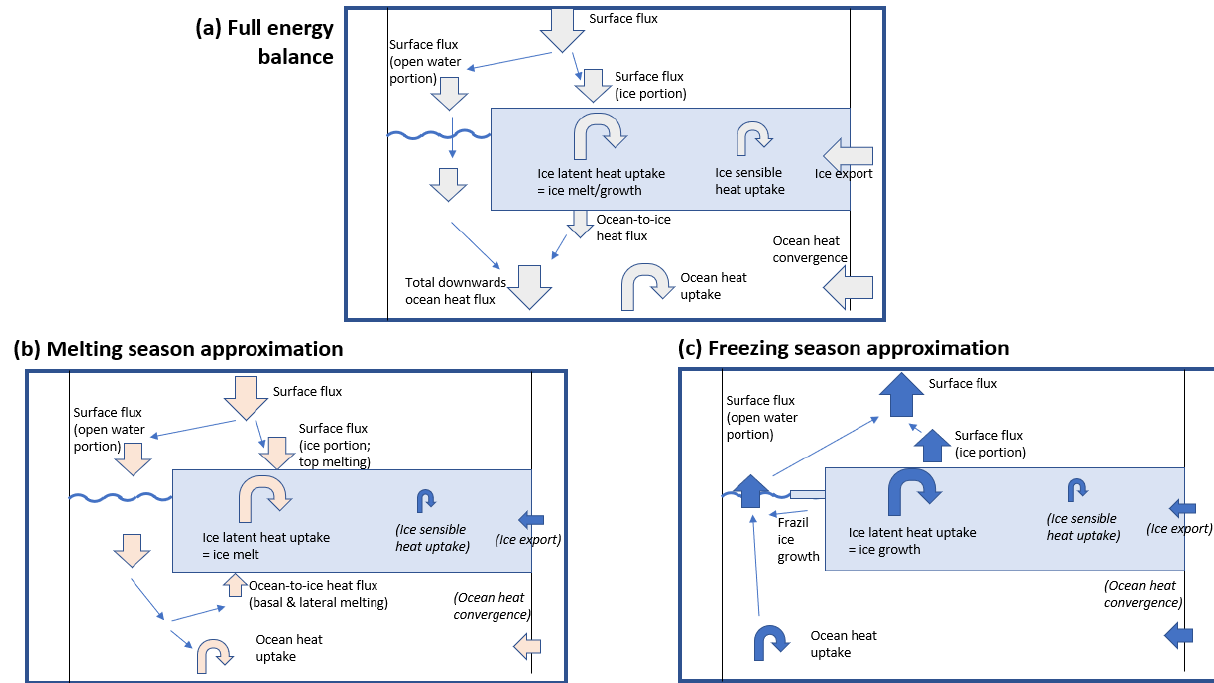
Figure 2. Schematics showing (a) the principal energy flows between atmosphere, ice and ocean in the Arctic and (b) how surface flux relates to ice melt and growth in the melting season. Panel (c) as (b) but for the freezing